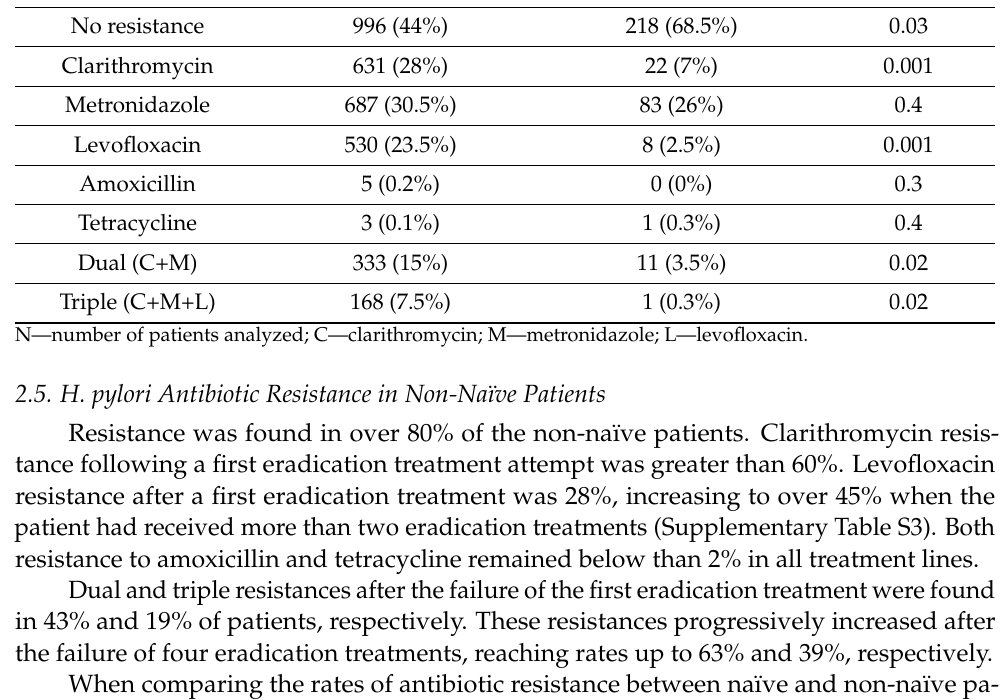
Table 3. Helicobacter pylori antibiotic resistance according to European geographical areas: southern Europe (Italy, Spain, and Greece) and northern Europe (Norway), in naïve patients. Resistance Southern Europe N